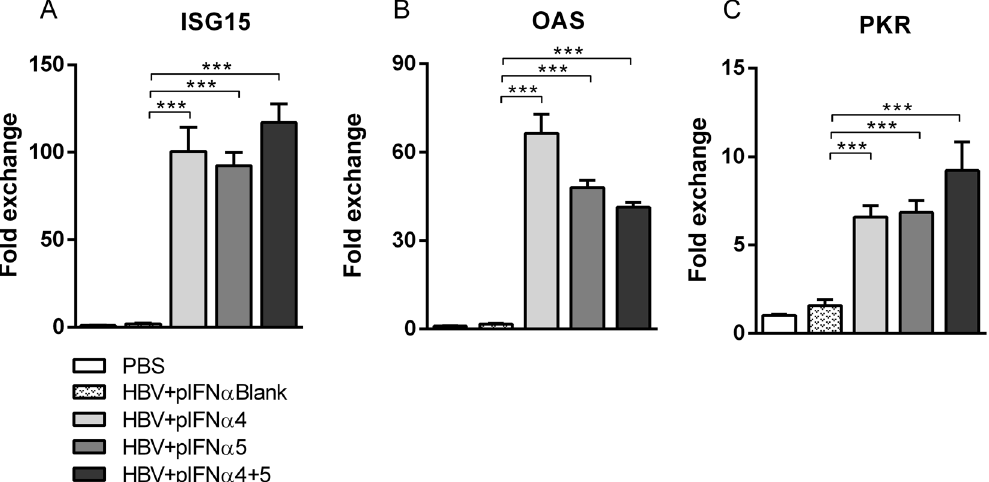
Figure 6. Induction of ISG15, OAS and PKR expression post treatment with plasmids encoding for different IFN α subtypes. Mice received HI with 10 µ g of pAAV-HBV1.2 plasmids in combination with 20 µ g of plasmids encoding for IFN α subtypes (pIFN α 4, pIFN α 5, pIFN α 4 + 5 or pIFN α Blank (empty vector)). Total RNA was extracted from liver tissue at day 4 post HI and the mRNA expression levels of ( A ) ISG15, ( B ) OAS and ( C ) PKR were determined by qRT-PCR. The β -actin mRNA expression was quantified for normalization. Each sample was run in duplicate and at least four mice per group were analyzed. Differences between the IFN-treated groups and the untreated control group were analyzed by using the One-way ANOVA. Statistically significant differences between the groups are indicated by *** for p < 0.001.